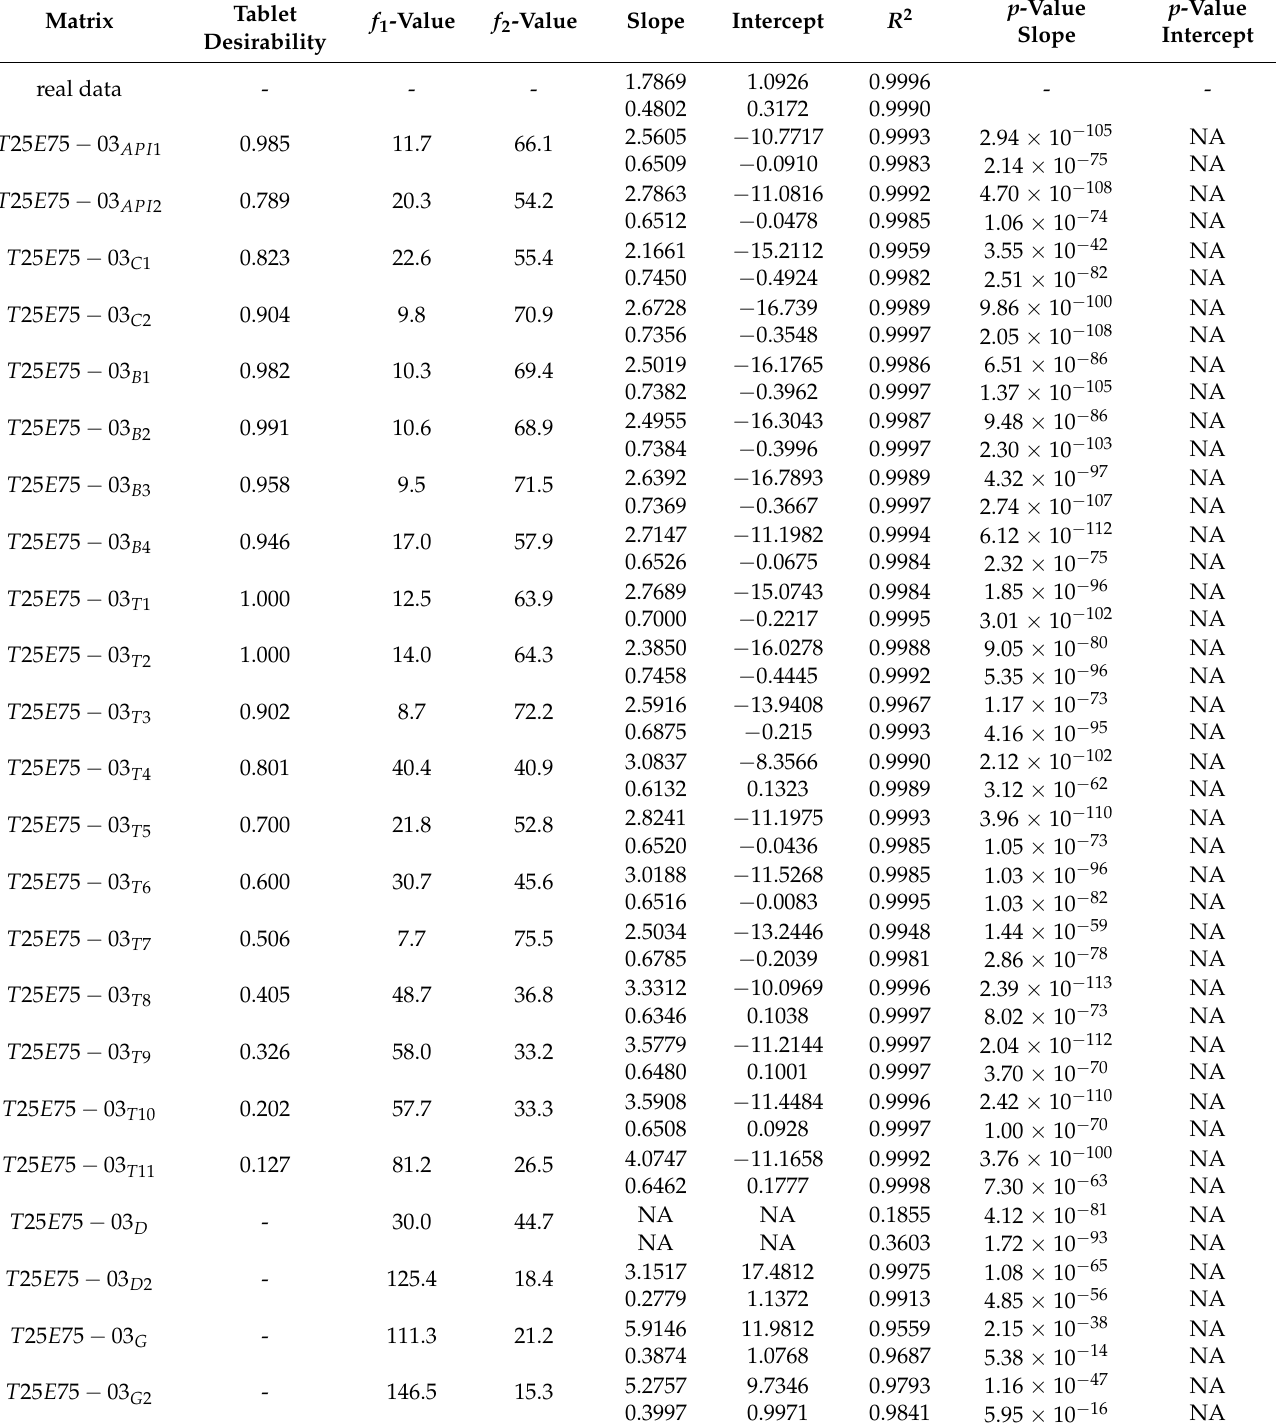
Table 3. The calculated results of the comparison of the predicted dissolution profiles and the experimental one. The first row in a cell is the value of the Higuchi plot, the second row represents the value of the Korsmeyers–Peppas plot. ’NA’ indicates that a value was not calculated because either there were too few data points or it was not necessary, e.g., if the slopes were significantly different, the p -value of the axis intercept was not